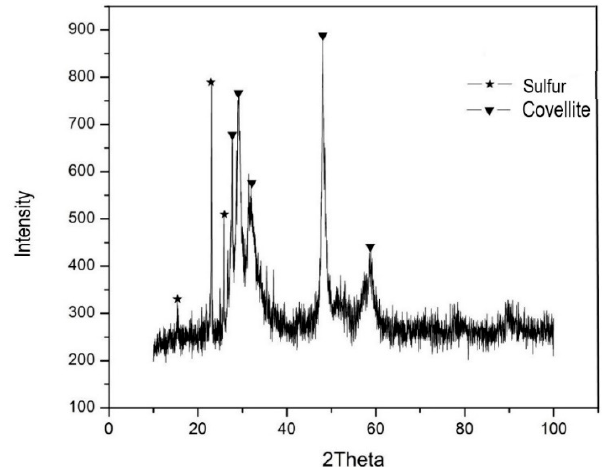
Figure 7. Residue diffractogram 4 days of leaching with 4 g/L of Fe 3+ , 20 g/L of H 2 SO 4 in conditions of 1 atm, 22 °C and 400 rpm.